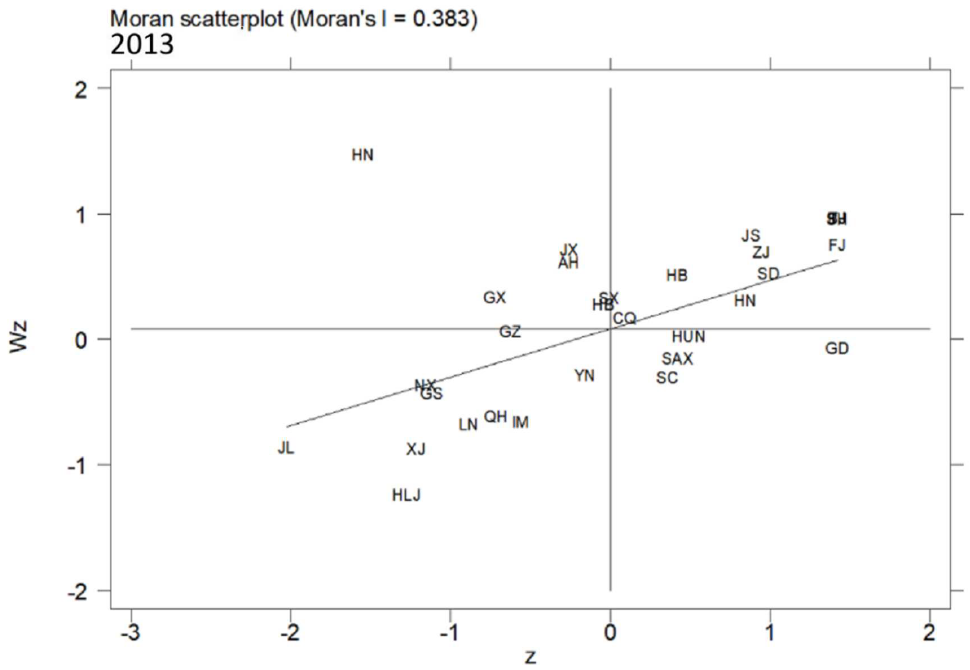
Figure 5. MSP map of ULGLE in 30 provinces in 2008.